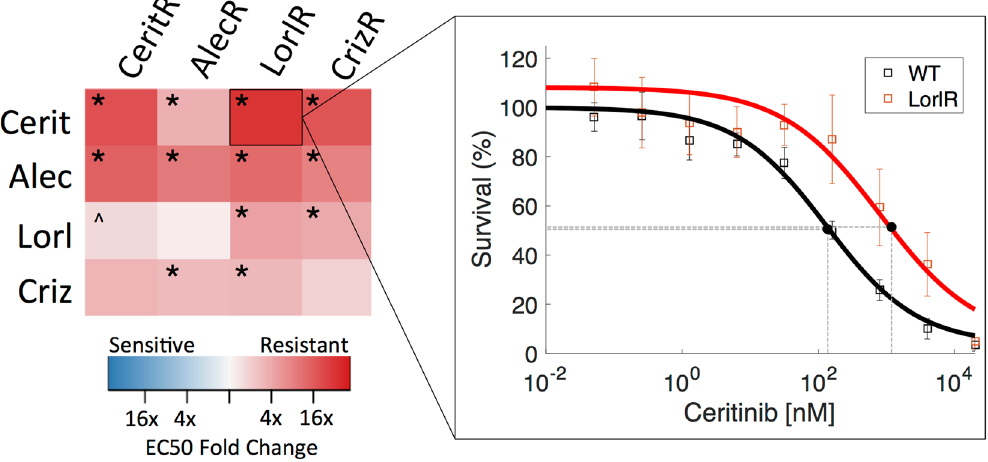
Figure 1. Left: Collateral sensitivity matrix of fold change of EC50 for resistant cell lines (columns) as treated by the panel of ALK TKIs (rows). All sequences of therapy resulted in cross-resistance except alectinib followed by lorlatinib, which was neutral. Right: Pop-out figure shows example of EC50 comparison in case of collateral resistance of lorlatinib resistant cells treated with ceritinib, as compared to treatment-naive (WT). Experimental data (markers) and model fit (solid lines) are shown. The asterisk ( * ) refers to a significant change in EC50 from treatment-naive, with non-overlapping 95% confidence intervals, and the caret (^) refers to a case in which the confidence intervals for the EC50 in one of the treated or treatment-naive cases was indeterminate. Non- significant changes are those not demarcated by either